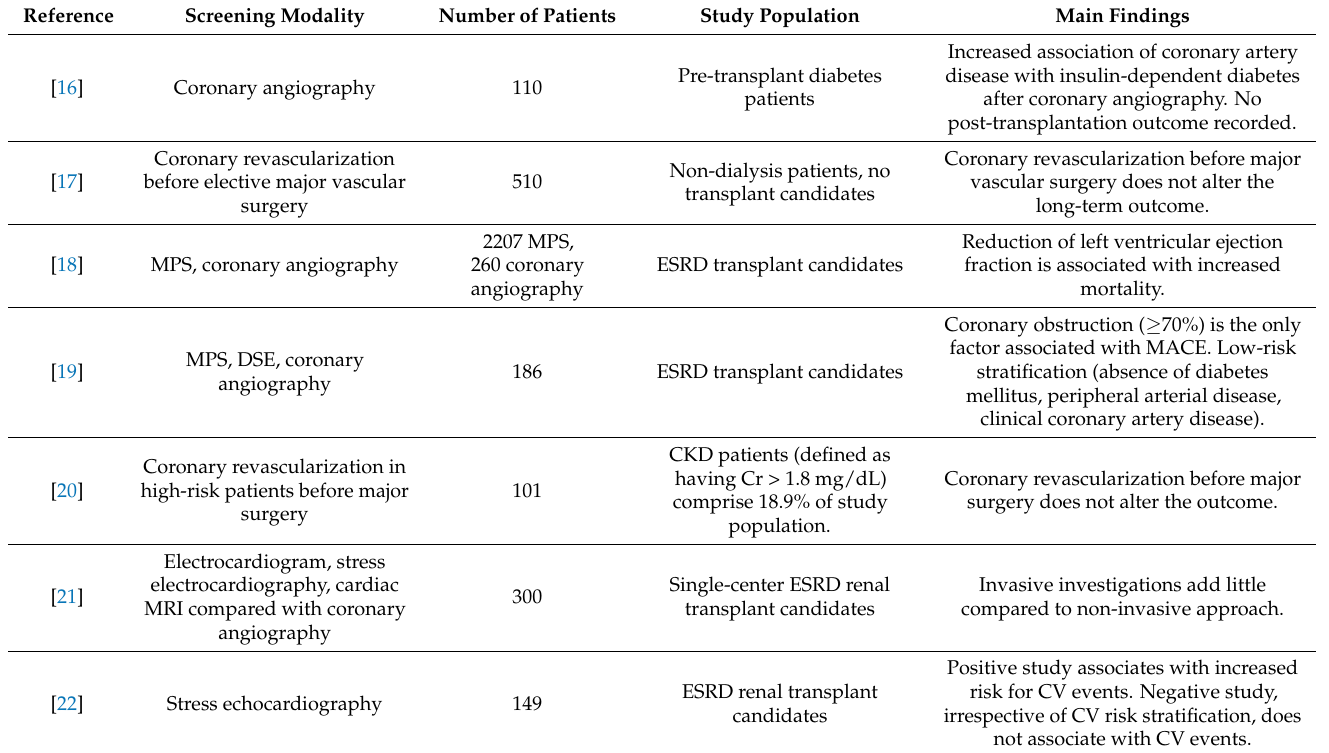
Table 1. Studies examining the effect of various methods of screening for cardiovascular morbidity on cardiovascular outcomes in renal transplant